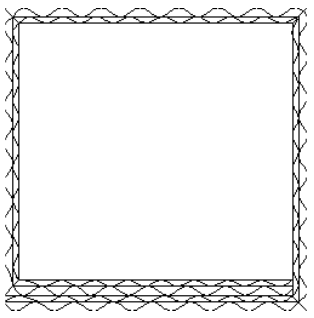
Figure 1: Full lapped adhesion of paper corrugation tubes